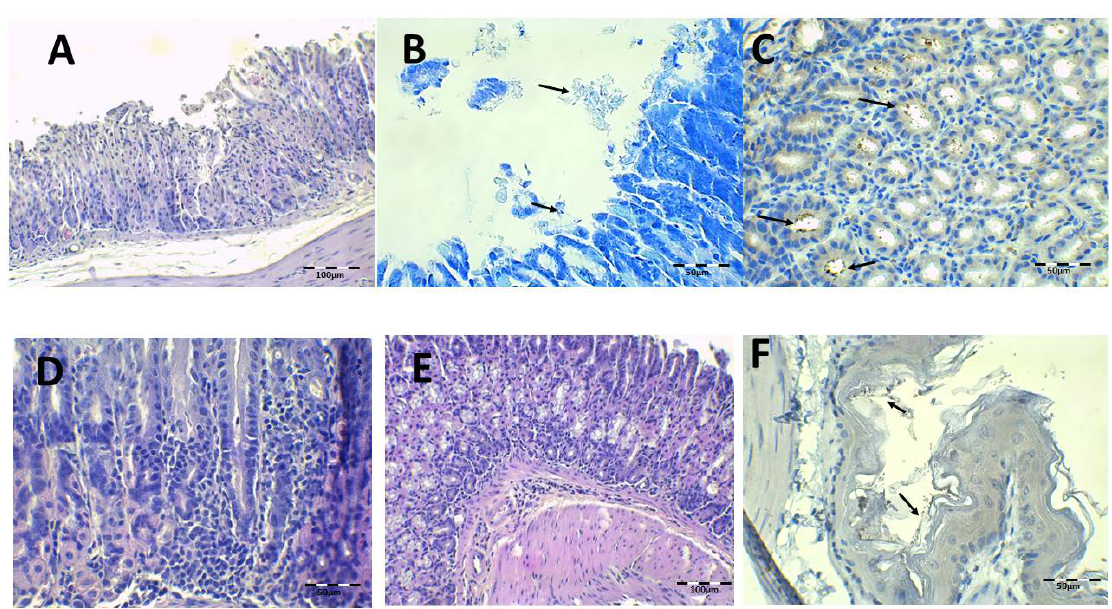
Figure 9. Control, PBS-infected animal microphotographs of the stomach ( A – E ) and esophagus ( F ) stained with H-E ( A , D , E ), Giemsa ( B , arrows indicate H. pylori bacteria), and IHC ( C , F , arrows indicate H. pylori bacteria).